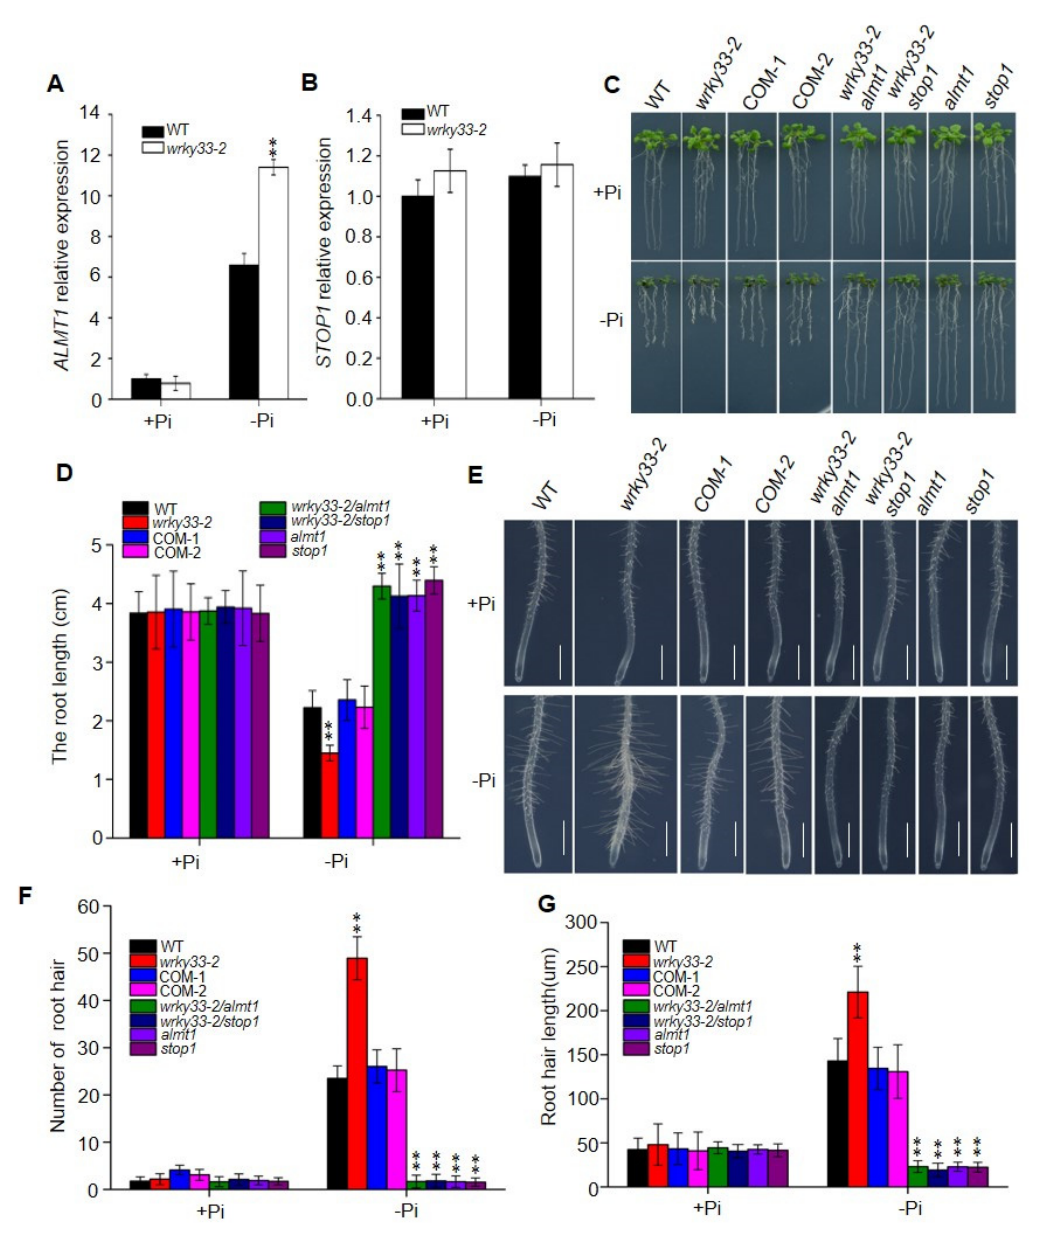
Figure 5. WRKY33 interacts with ALMT1 to regulate Pi deficiency responses. ( A , B ) The RT-qPCR assay of ALMT1 ( A ) and STOP1 ( B ) expression in wild-type (WT) and wrky33-2 mutant plants. Four-day-old seedlings were grown on a Pi-sufficient (+Pi) or a Pi-deficient ( − Pi) medium for three days. The whole plants were excised for RNA extraction and qRT-PCR analysis. ACTIN2 was used as the internal reference gene. ( C ) The growth phenotype of WT and mutants on +Pi and − Pi media. Four-day-old seedings were transferred to a Pi-sufficient (+Pi) or a Pi-deficient ( − Pi) medium for six days. ( D ) The statistical analysis of the primary root length as indicated in ( C ). Data are means ± SD from three independent experiments ( n = 15; n represents the number of samples). ( E ) Root hair growth in WT, wrky33-2 , complementation lines, wrky33-2 almt1 , wrky332 stop1 , almt1 , and stop1 seedlings. Four-day-old seedings were transferred to a Pi-sufficient (+Pi) or a Pi-deficient ( − Pi) medium for three days. Bar=200 µ M. ( F , G ) The root hair number ( F ) and the root hair length ( G ) as indicated in ( E ). The hair density and length measured within a 1 mm zone in the root starting from the root tip. Data are means ± SD from three independent experiments ( n = 15; n represents the number of samples). Asterisks in ( A , B , D , F , G ) indicate a significant difference from the WT (Tukey’s test; **, p <